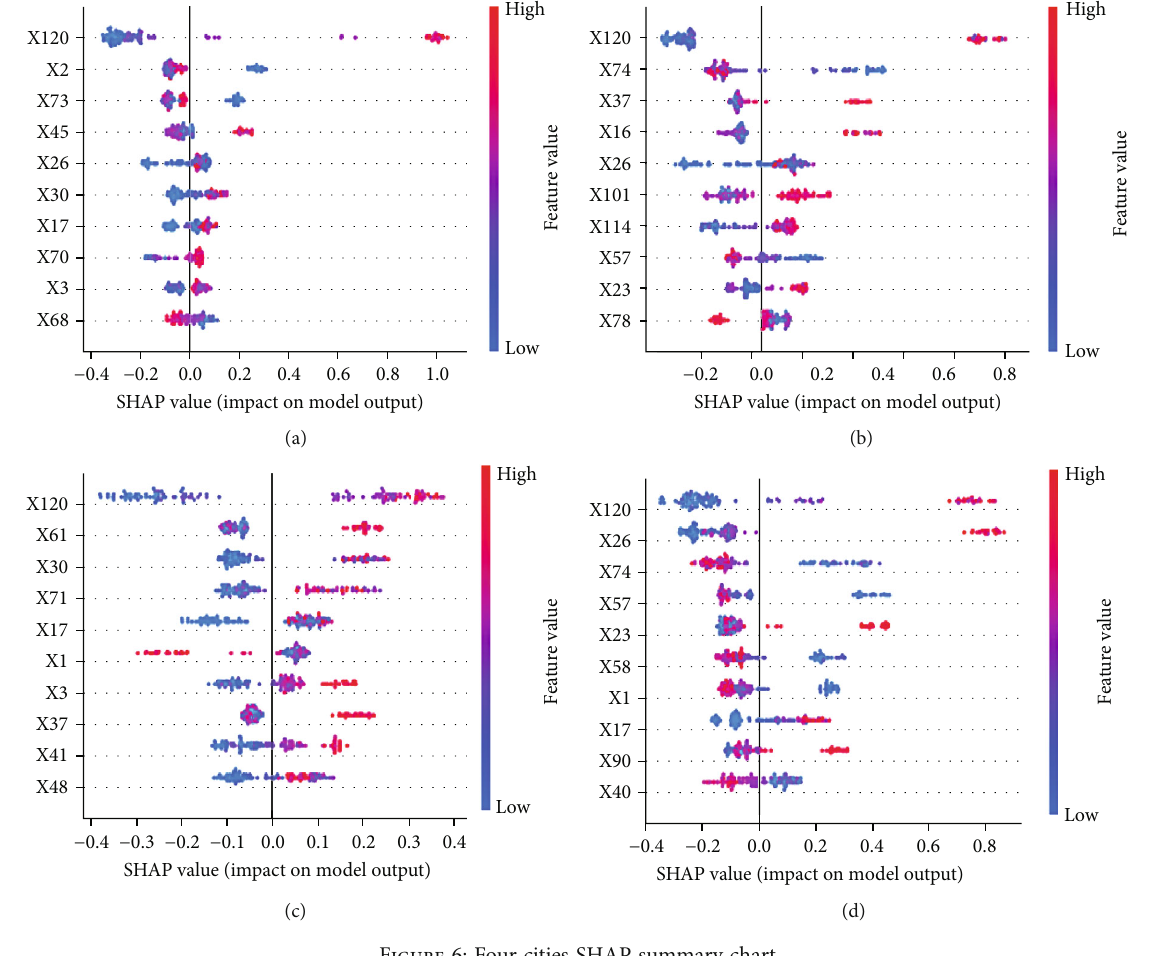
Figure 6: Four cities SHAP summary chart. Table 5: Four cities in order of importance of keyword